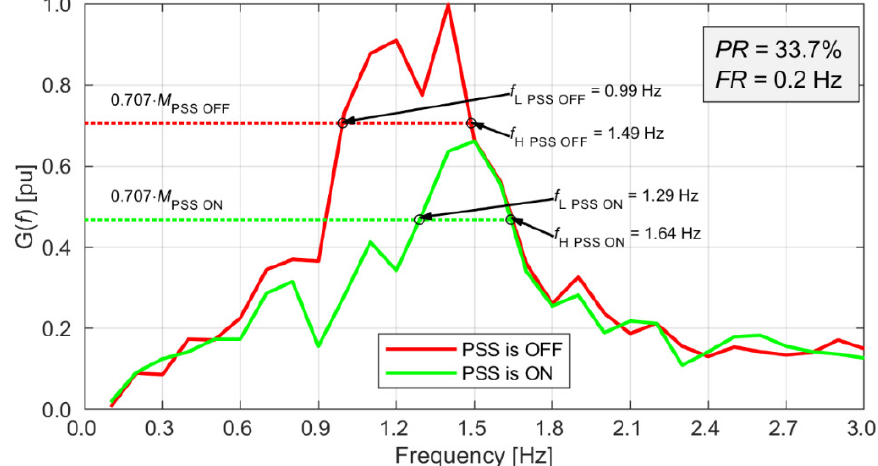
Figure 15. G PSS OFF ( f ) and G PSS ON ( f ), P g = 140 MW, Q g = 0 Mvar [42].